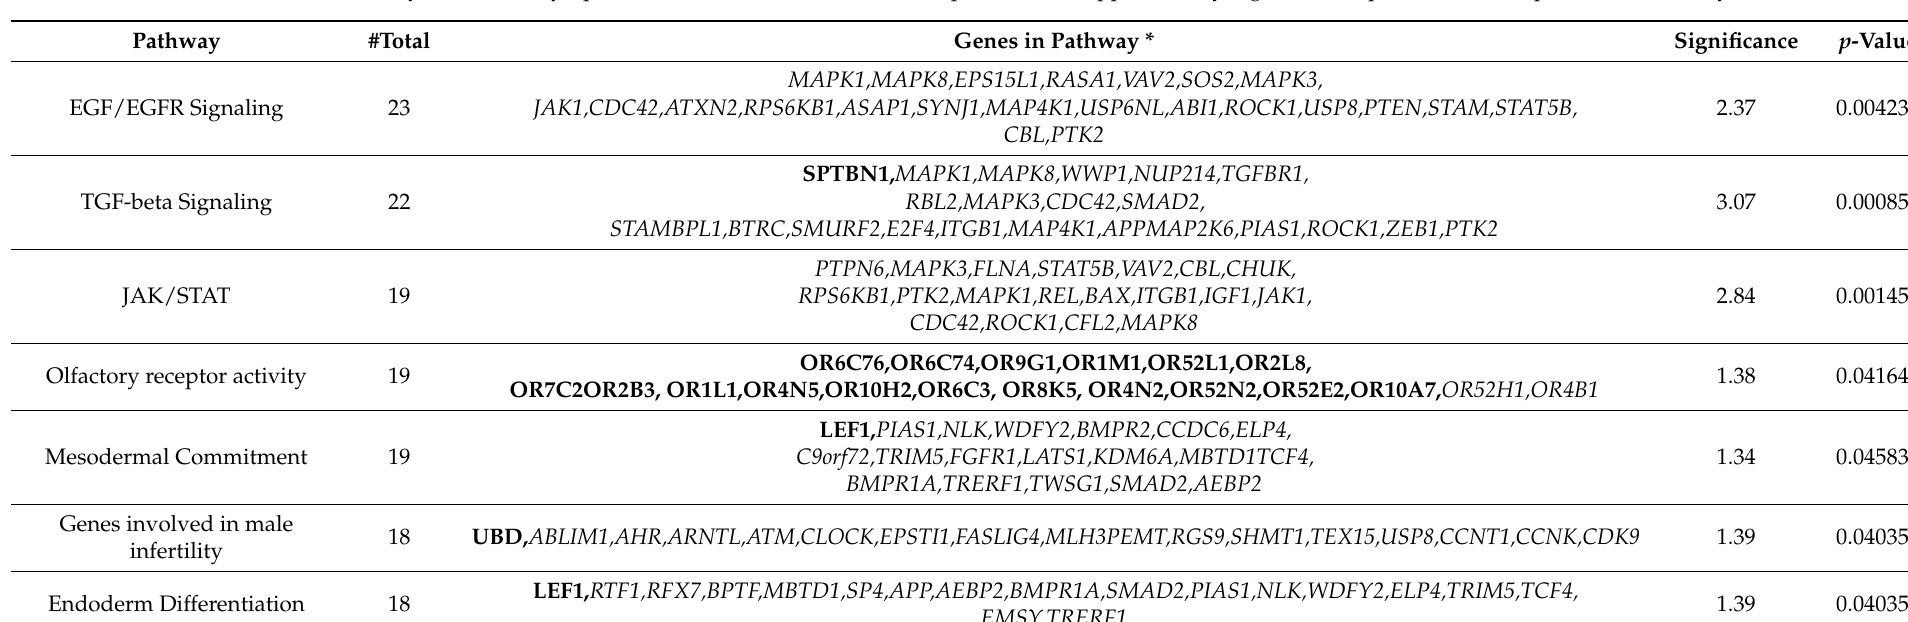
Table 4. WikiPathways affected in lymphoblastoid cells derived from an SS patient. See Supplementary Figures for depictions of the top five